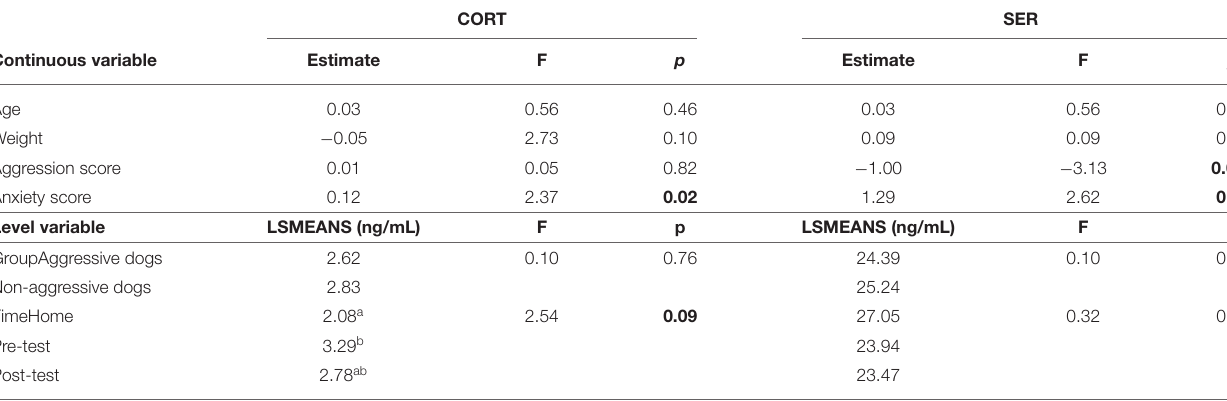
TABLE 3 | Effects of variables tested on CORT and SER.